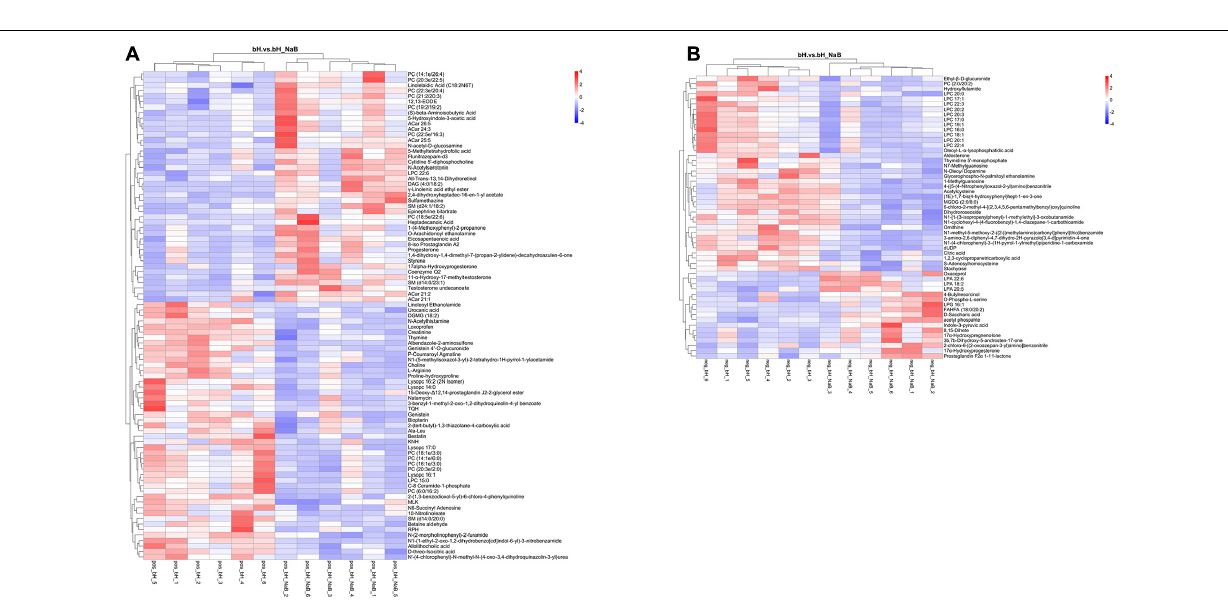
Frontiers in Marine Science |